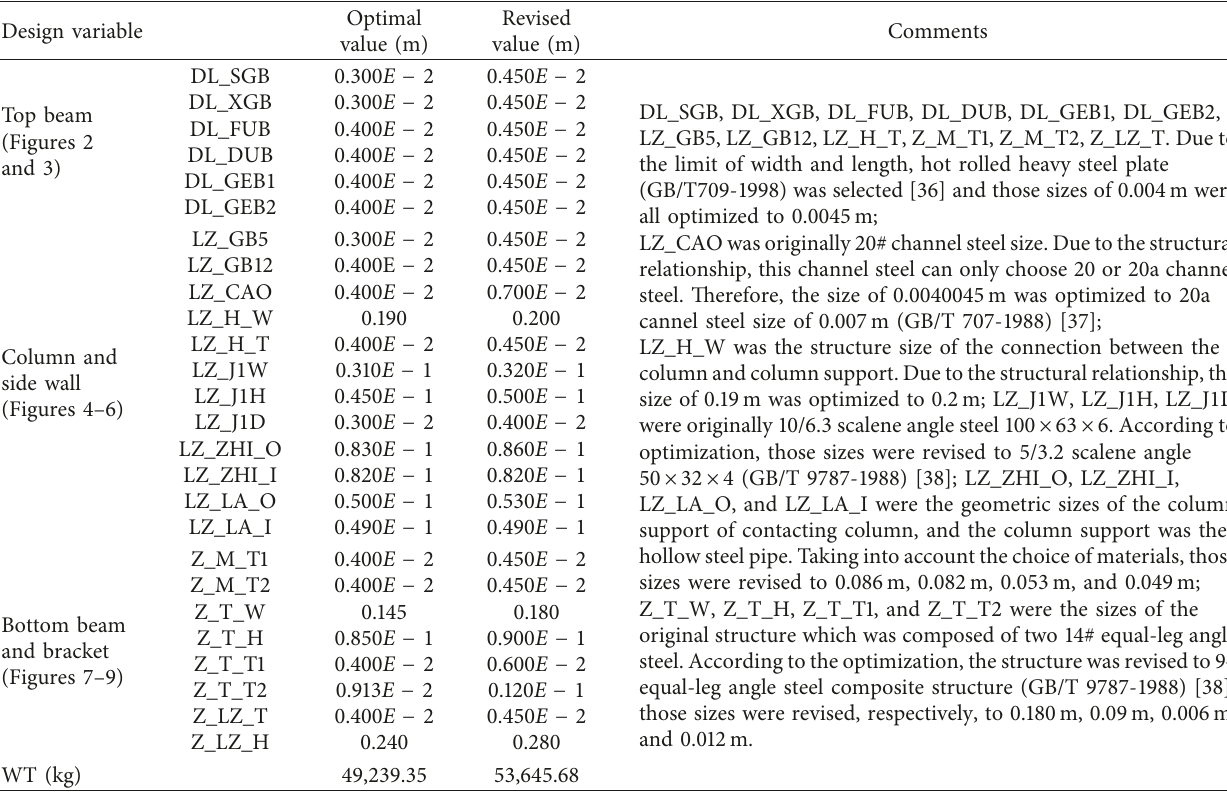
Table 13: The optimization